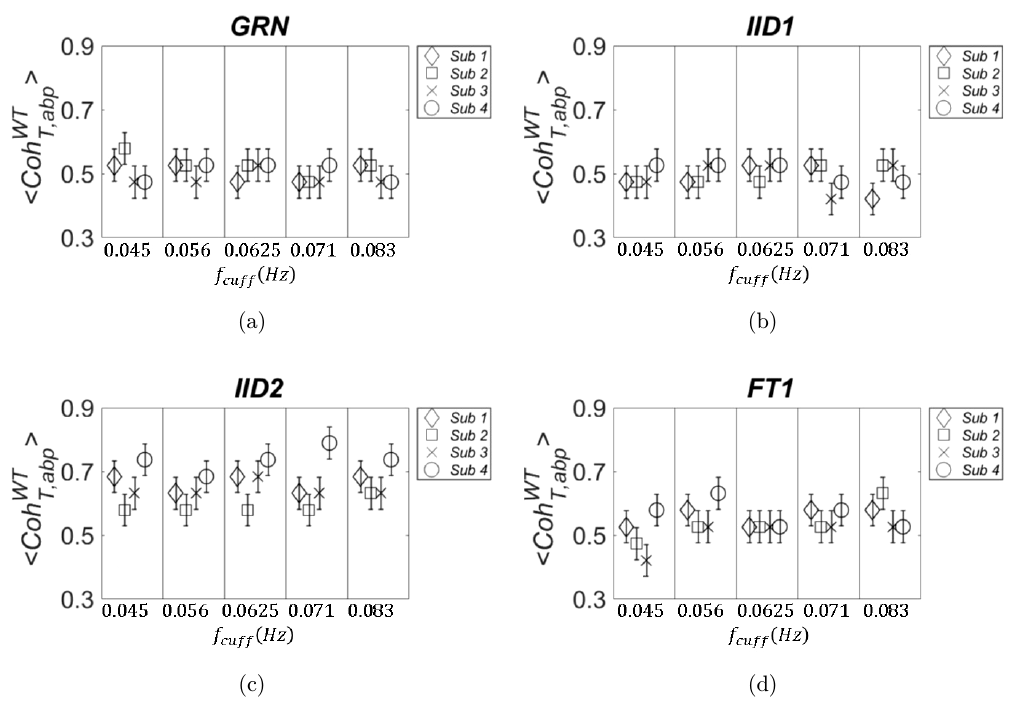
i are shown for the four subjects. They refer to GRN abp